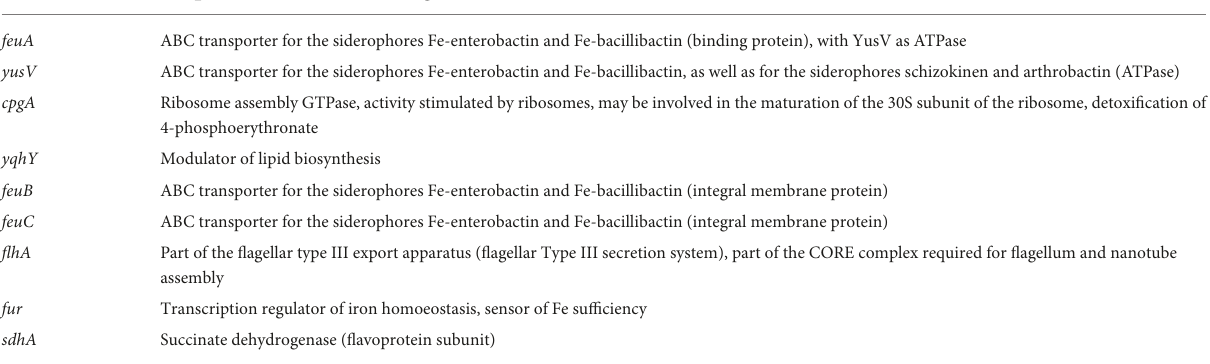
TABLE 1 Deletion strains that exhibit hypersensitivity to mirubactin